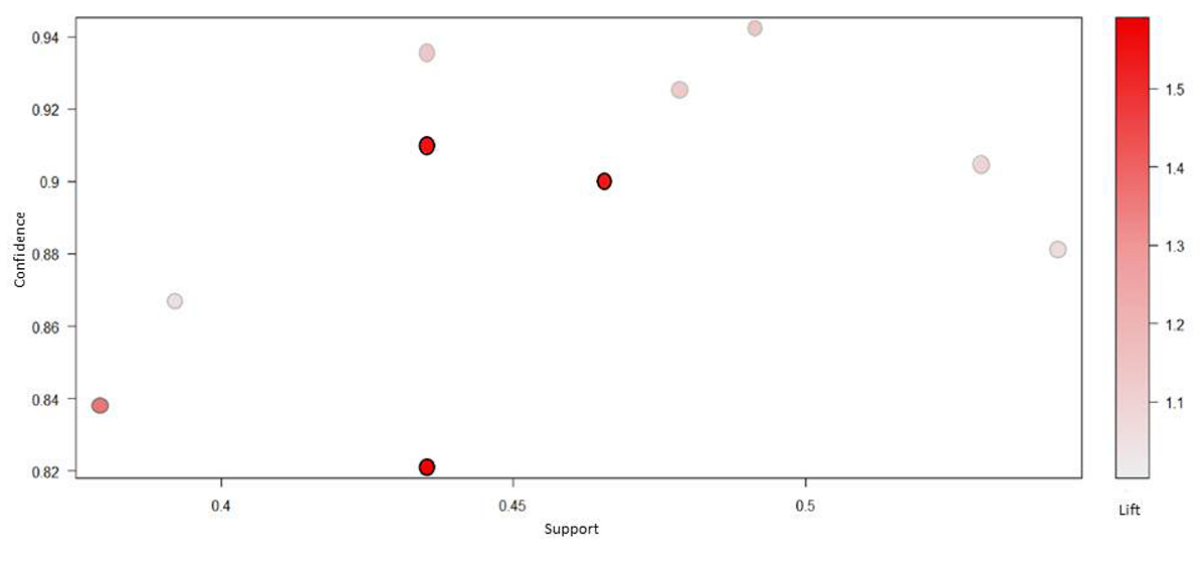
Figure 3. Top 10 association rules. The figure shows the plot with lift on the y-axis.